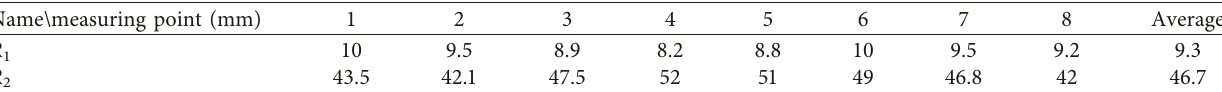
Figure 13: The schematic of rock blasting. O : charge; d 0 : charging diameter; r 1 : crushing zone; r 2 : fissure zone. Table 6: The radius of the crushing zone and fissure zone measured in the transparent model specimen.